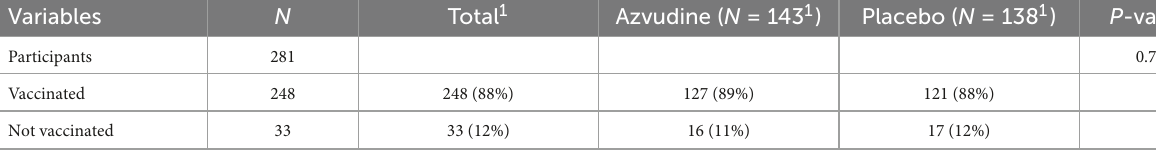
TABLE 3 Quantification of vaccinated and unvaccinated participants included in the study.